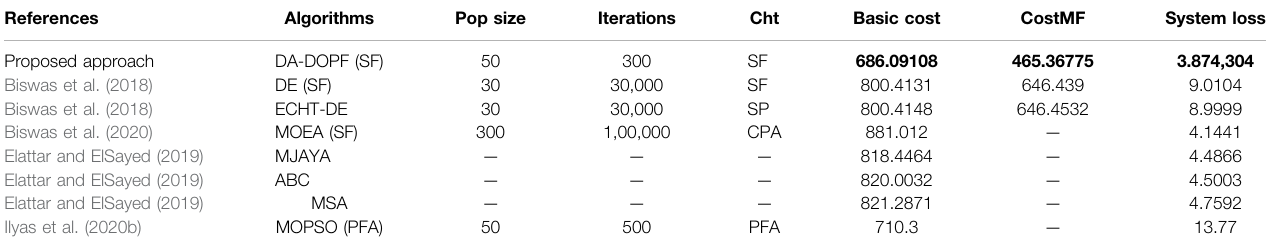
TABLE 10 | Comparison with existing techniques. Cht (cid:2) constraint handling technique. Basic and other cost are calculated in (cid:2) $/h. System loss is calculated in MW (mega watts).